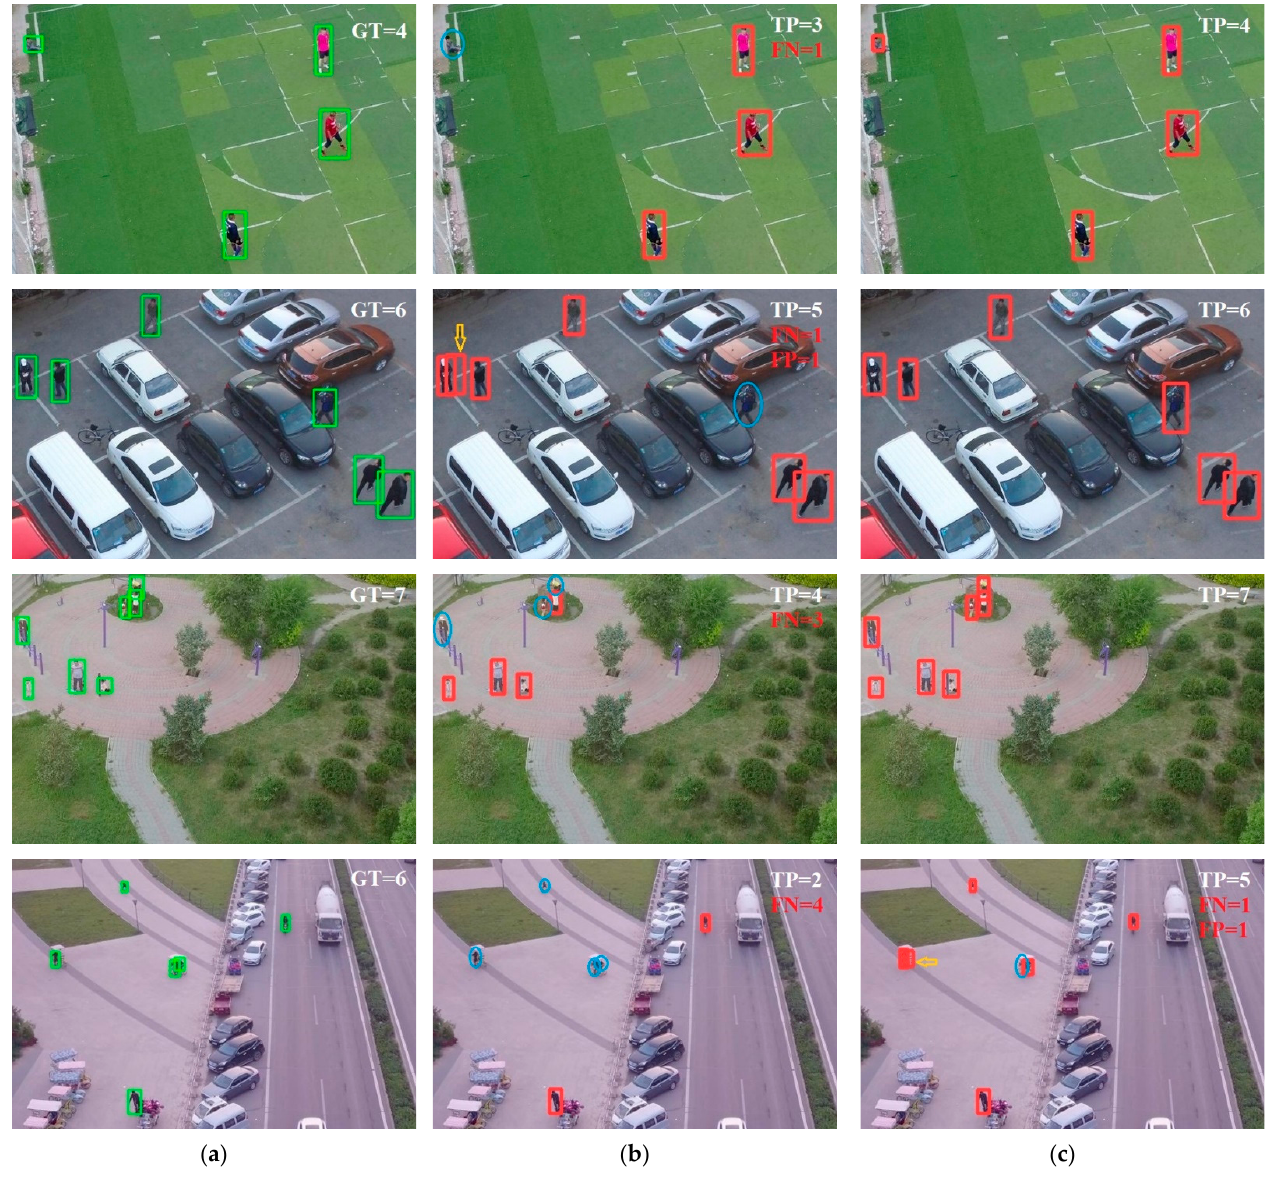
Figure 10. The detection results of different methods: ( a ) ground truth; ( b ) original YOLOv5s; ( c ) YOLOv5s_P2+ compression. The ground truths are marked by green boxes. Prediction results are marked by red boxes. The missed detections are marked by blue ellipses. The false detections are marked by yellow arrows. GT means the number of ground truths. TP means the number of right detections. FN means the number of missed detections. FP means the number of false detections.